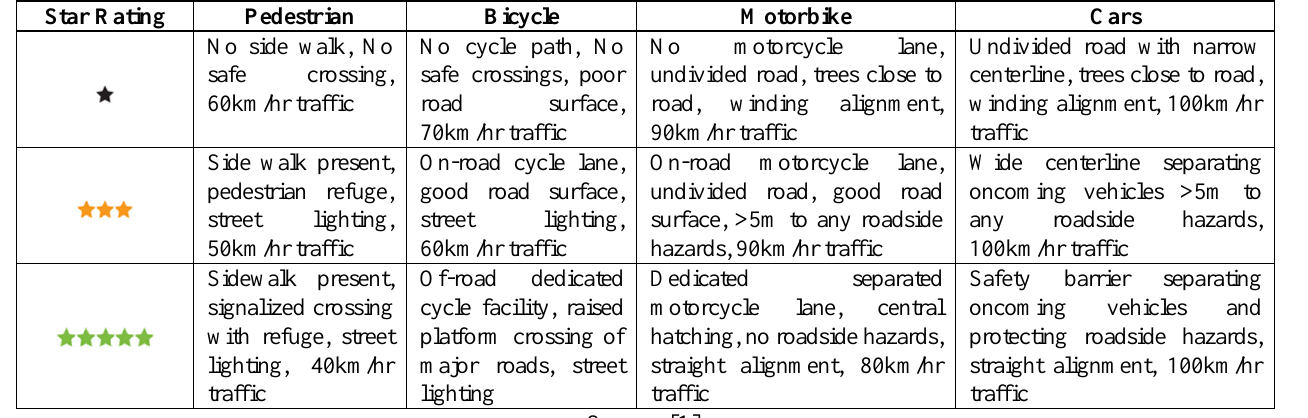
Figure 5: Prioritizing routes using risk rates and Star Rating Scores. Source: [29]. Table 1: Criteria for Star